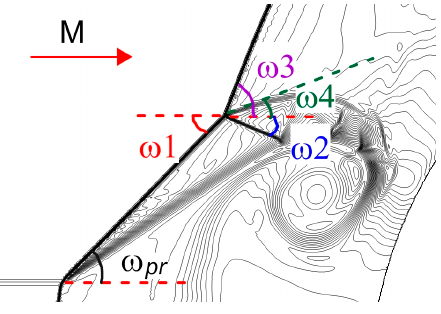
Figure 4. Considered angles.